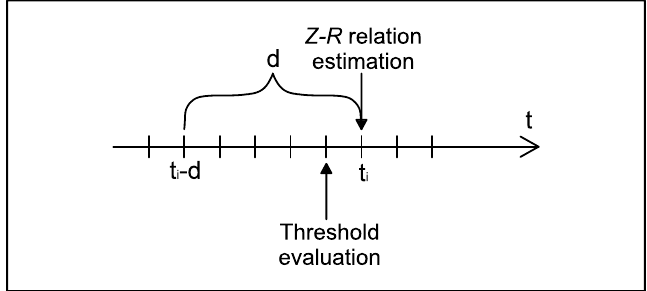
Figure 1. Schematic representation of the temporal estimation